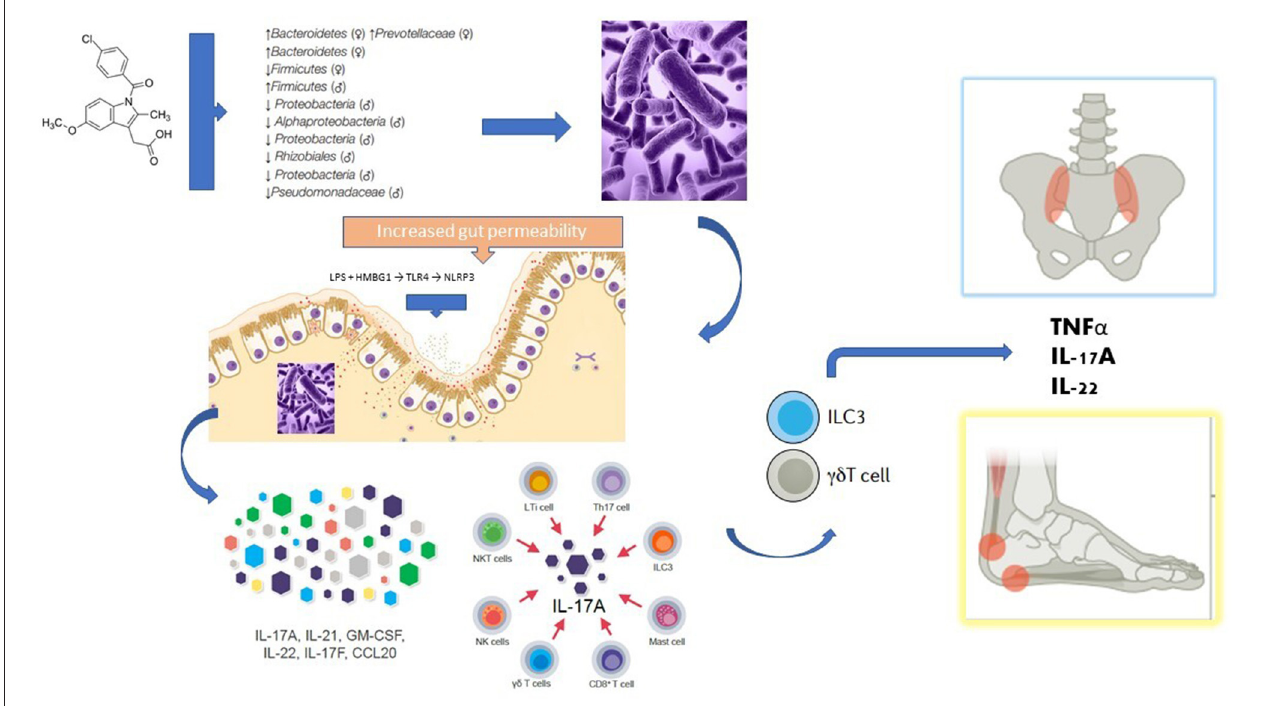
FIGURE 1 | Potential mechanisms linking the use of NSAIDs with the gut-joint axis theory in the pathogenesis of spondyloarthritis. NSAIDs (in this case exemplified by indomethacin) can modify the growth and imbalance the composition of the intestinal microbial communities (a condition known as dysbiosis). Once substantial damage is generated to the defense mechanisms of the intestinal mucosa, and pathogenic bacteria and their products reach deeper layers of the intestine, it is believed that a special type of immune response called type 3 immunity is activated in the lamina propria. In SpA patients, several cell lineages with the potential to produce IL-17 are increased in the blood, including mucosal-associated invariant T cells, Th17 cells, γδ T cells and type 3 innate lymphoid cells (ILC3), all of which have been implicated in mucosal immunity. Human entheseal tissue contains IL-23-responsive γδ T cells and ILC3 cells and these cells are important producers of IL-17 and IL-22 in the blood and peripheral joint synovial fluid of patients with SpA. It is believed that these type 3 cells can reach distant joint structures through the bloodstream, whereby secreting proinflammatory cytokines they can generate synovitis, osteitis, and enthesitis (gut-joint axis). See text for a more detailed